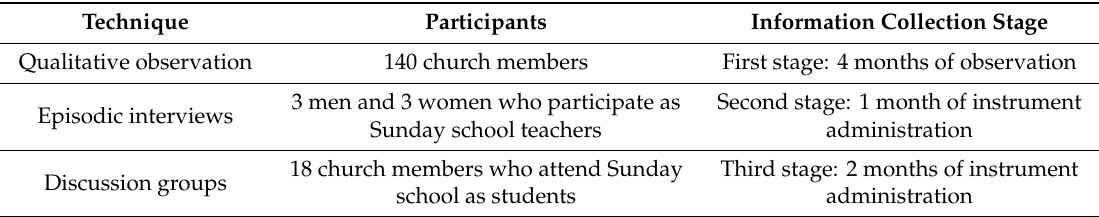
Table 1. Administration of the information collection